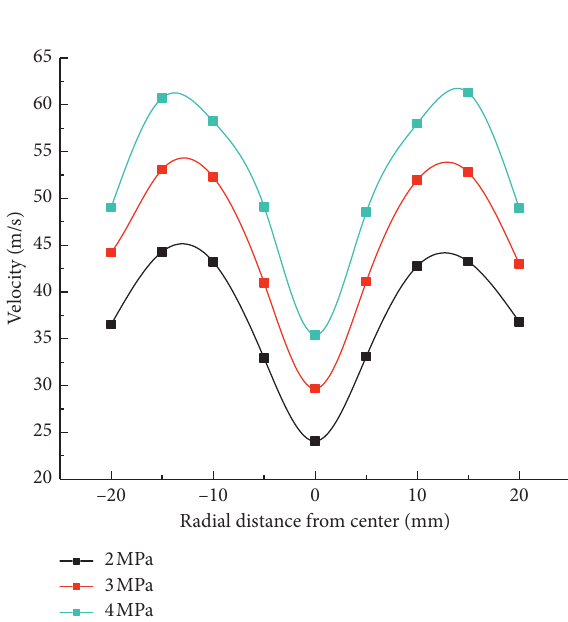
Figure 13: Radial velocity curve of Section 2.